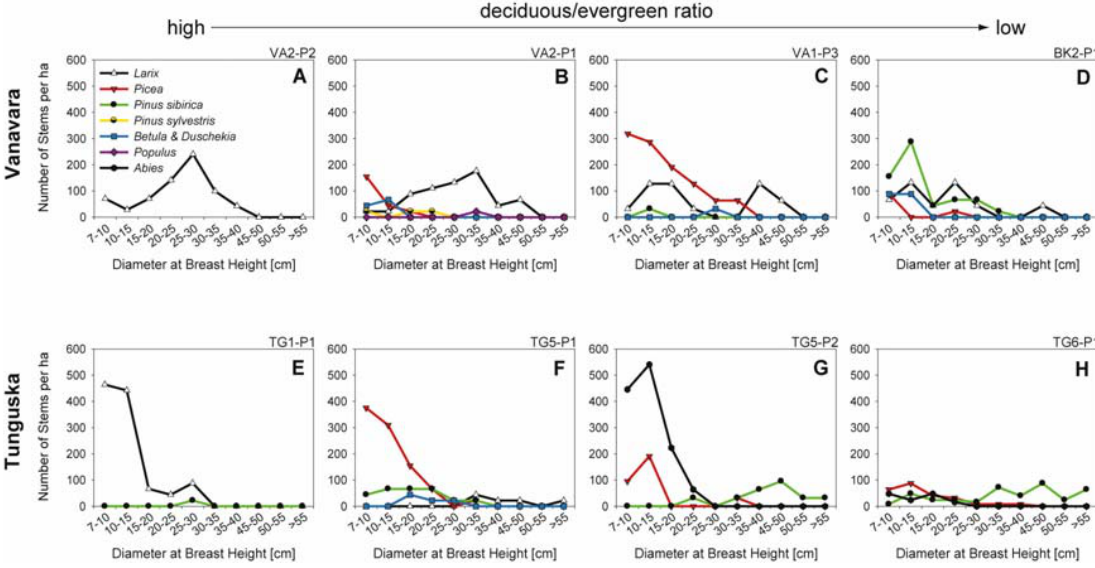
Fig. 4 Fig. 4. Stand density (number of stems per area) as related to diameter at breast height of selected plots representing an increasing ratio of deciduous to evergreen stems for the Vanavara-Bajkit region ( A to D ) and the Tunguska canyon ( E to H ).